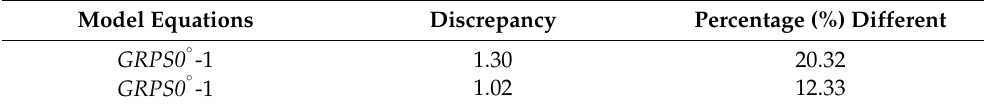
Table 8. Discrepancy Data for Validation of Model Testing.